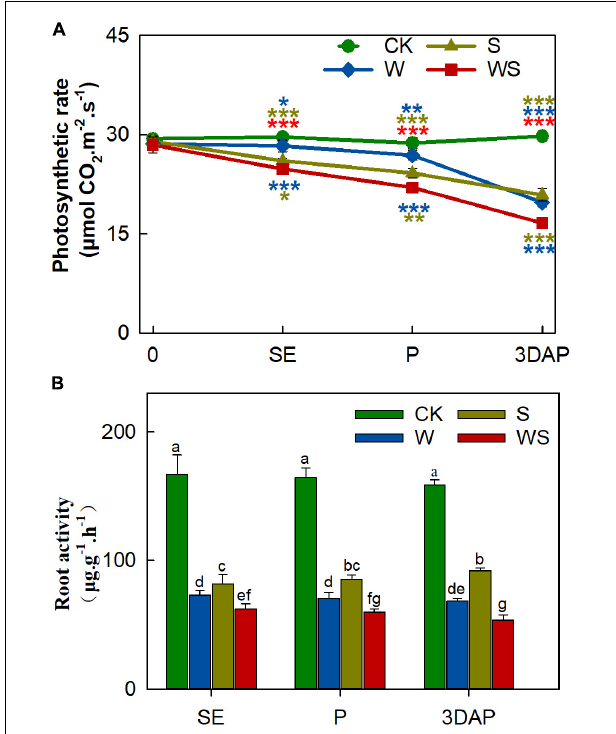
FIGURE 1 | Photosynthetic rate (A) and root activity (B) of plants in control (CK), waterlogging + shading (WS), waterlogging (W), and shading (S) treatment groups. Photosynthetic rate was taken at start of all treatments (0) and at SE (first silk emergence), P (full silk emergence), and 3DAP (3 days after pollination). Root activity was taken at SE, P, and 3DAP. Data were subjected to one-way ANOVA followed by Duncan’s new multiple range test. Different letters above bars indicate significant differences. Colored asterisks above line chart indicate significant differences between CK and treatment groups, colored asterisks below indicate significant differences between WS and W or S groups. Error bars represent ± SD ( n ≥ 4). * P < 0.05, ** P < 0.01, *** P < 0.001 (ANOVA and t